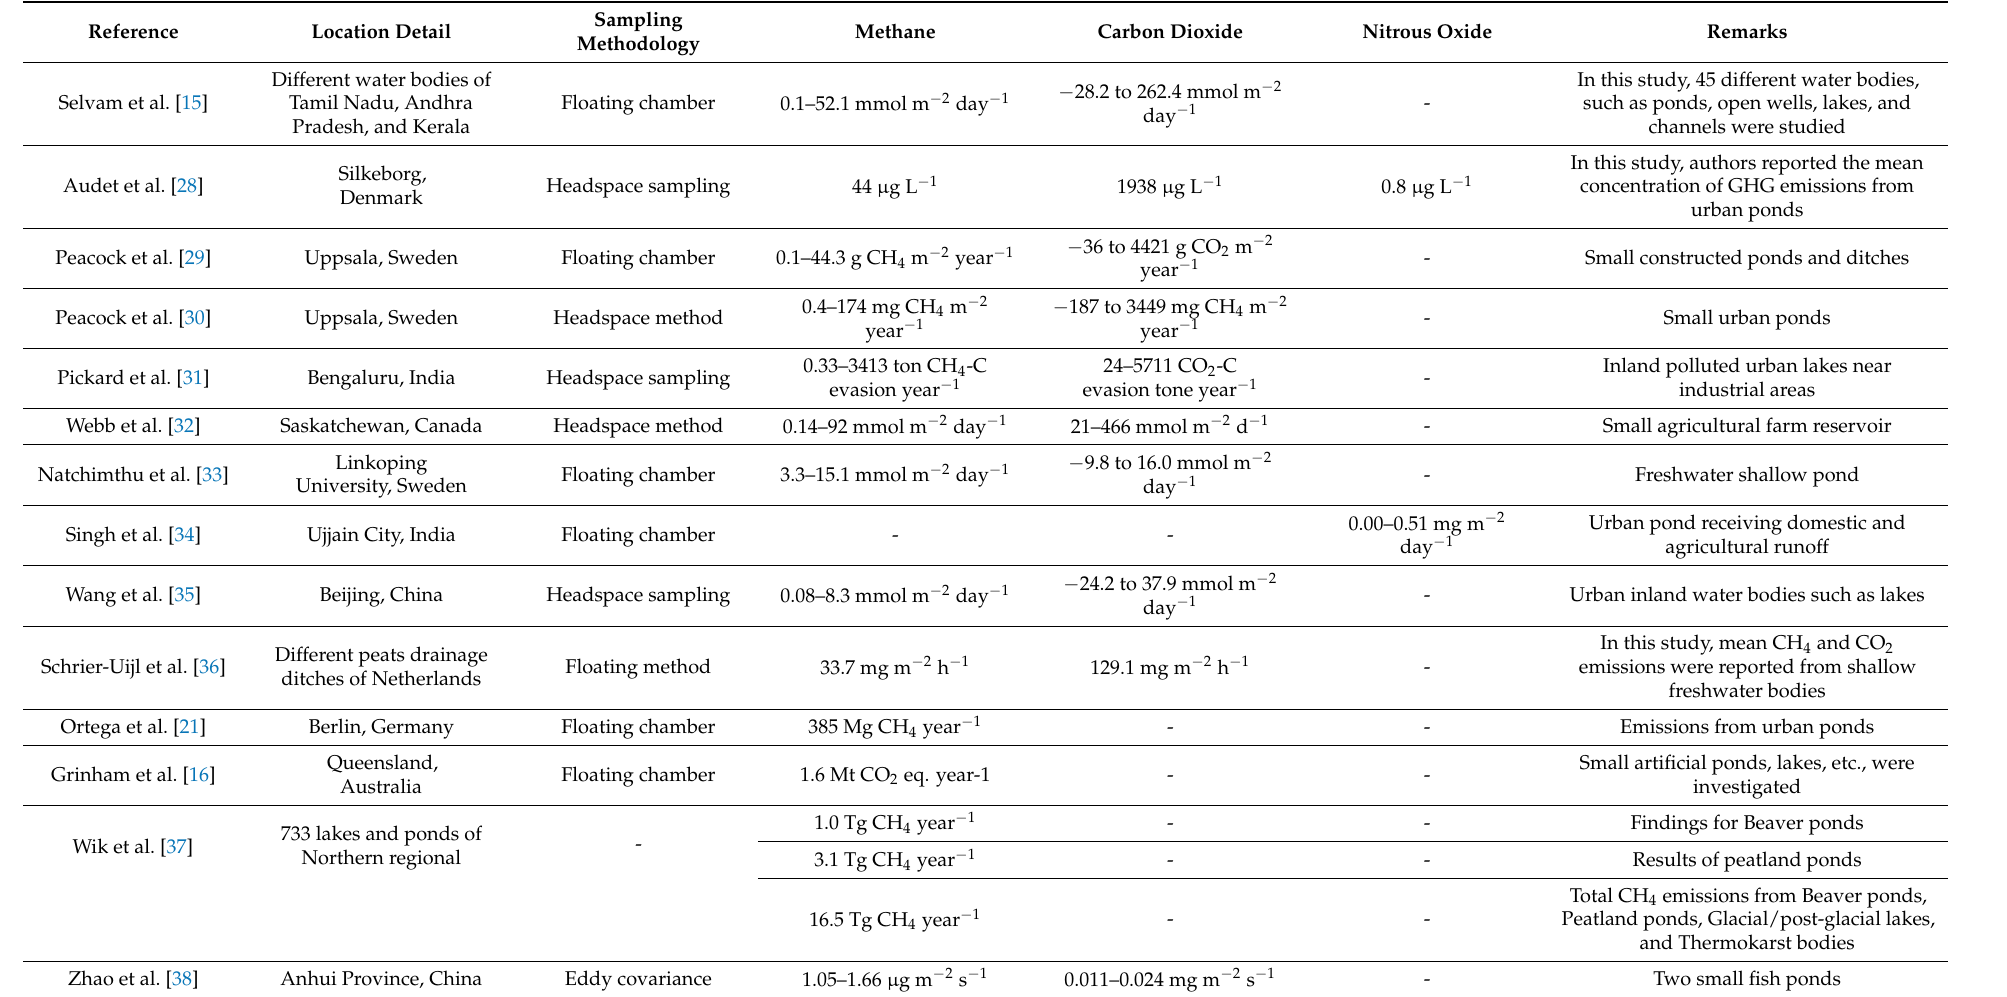
Table 1. Methane, carbon dioxide, and nitrous oxide flux ranges reported globally in different